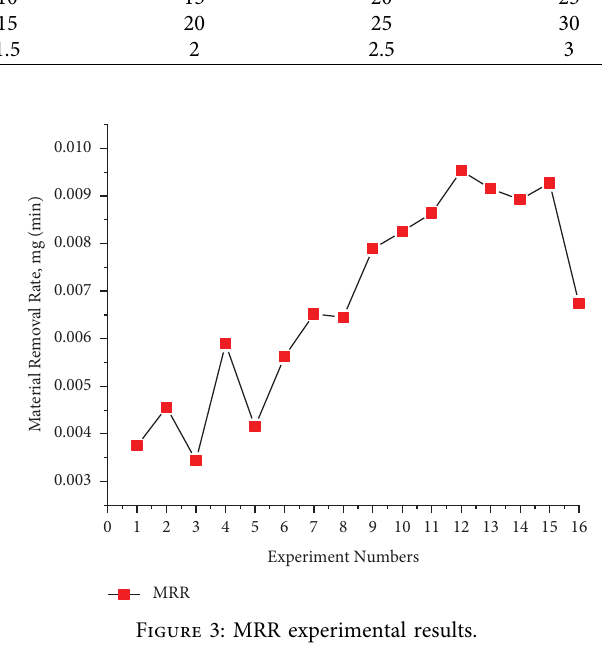
Figure 3: MRR experimental